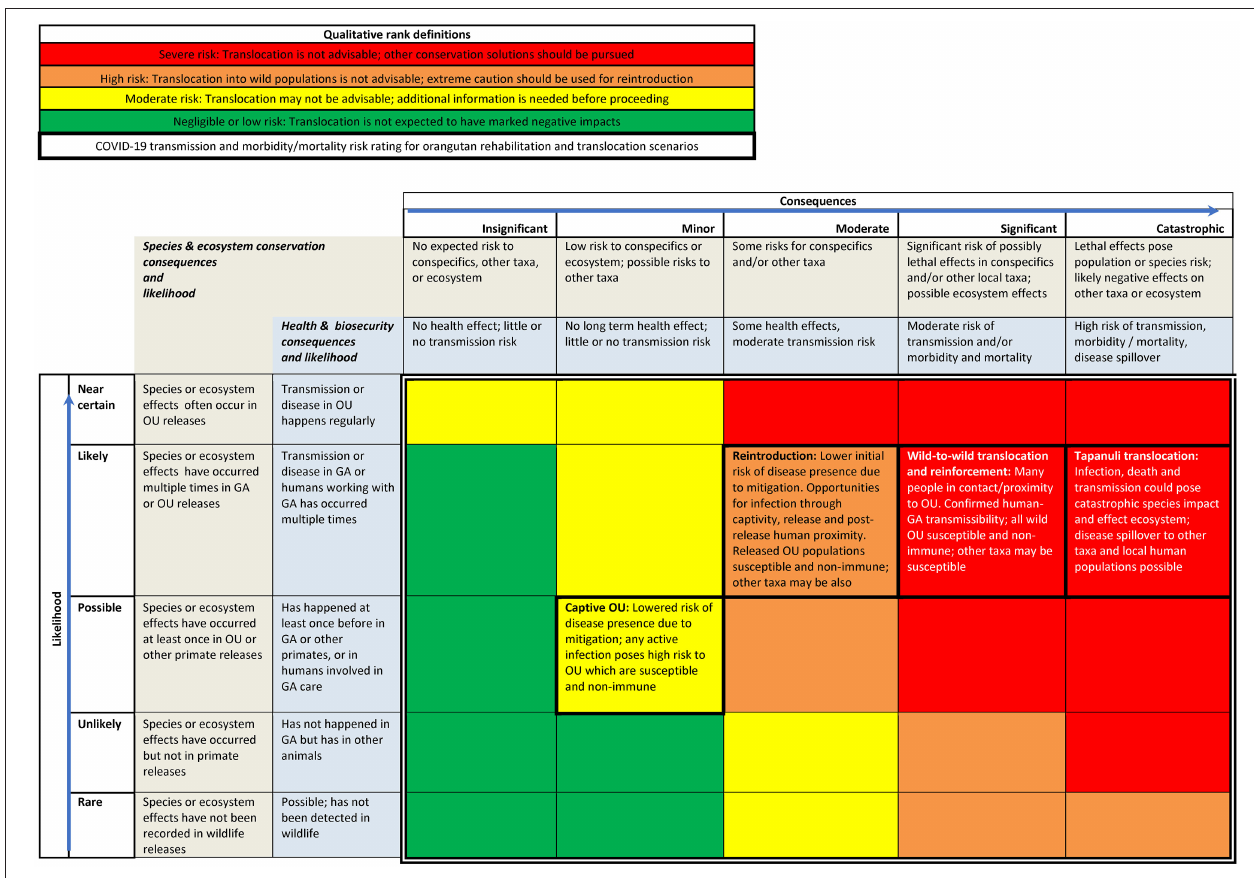
FIGURE 4 | Qualitative risk matrix for orangutan translocation using COVID-19 example. OU = orangutans; GA = great apes. Colored cells inside double lines denote overall qualitative rank. Consequence definitions are presented in the two cells beneath each category name, with species and ecosystems in the top cell and health and biosecurity in the cell below. Likelihood category definitions are presented in the two cells to the right of each category name, for species and ecosystems and then for health and biosecurity from left to right. Cells relevant to OU translocation scenarios have a thick border and list factors considered in risk ranking.